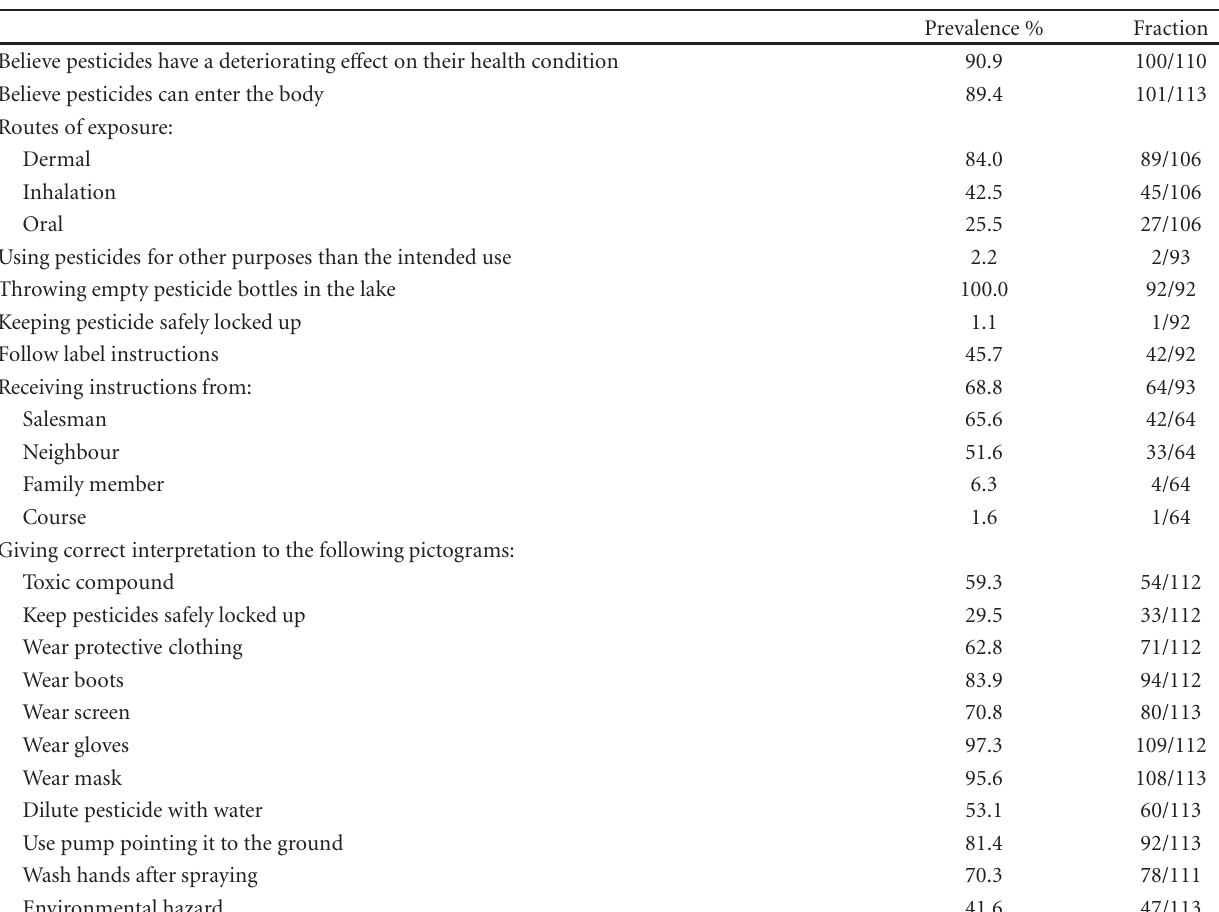
Table 2: Knowledge and attitudes towards pesticides among 113 farmers in Boeung Cheung Ek Lake, Phnom Penh,